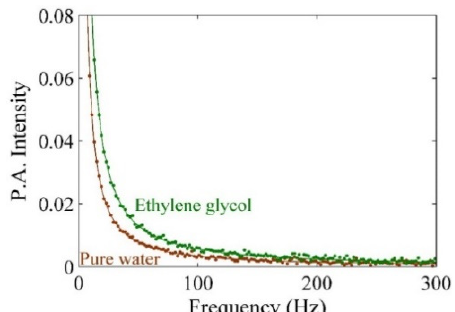
Figure 6. Photoacoustic signals to obtain the setup constant for calibration and test the setup. The thermal effusivity of DDW and pure ethylene glycol are 0.159 W s 1/2 cm − 2 K − 1 and 0.093 W s 1/2 cm − 2 K − 1 , respectively.